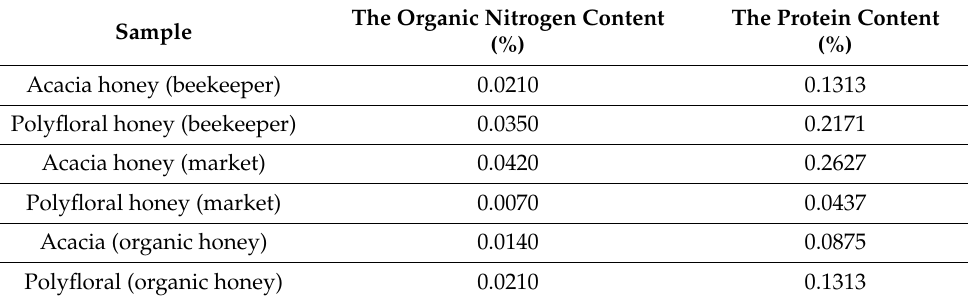
Table 4. The total nitrogen content and the protein content ( n =